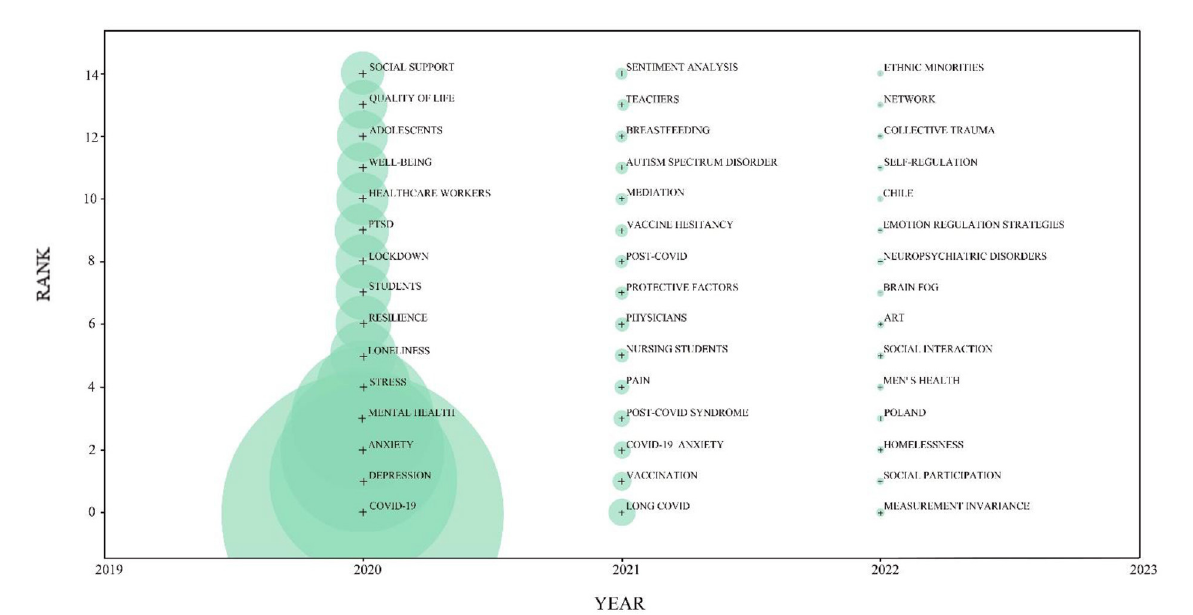
FIGURE9 Emerging trends of research on depression during COVID-19. The nodes represent keywords. The node size indicates the number of keyword occurrences. The year corresponding to the node is the year in which the keyword first